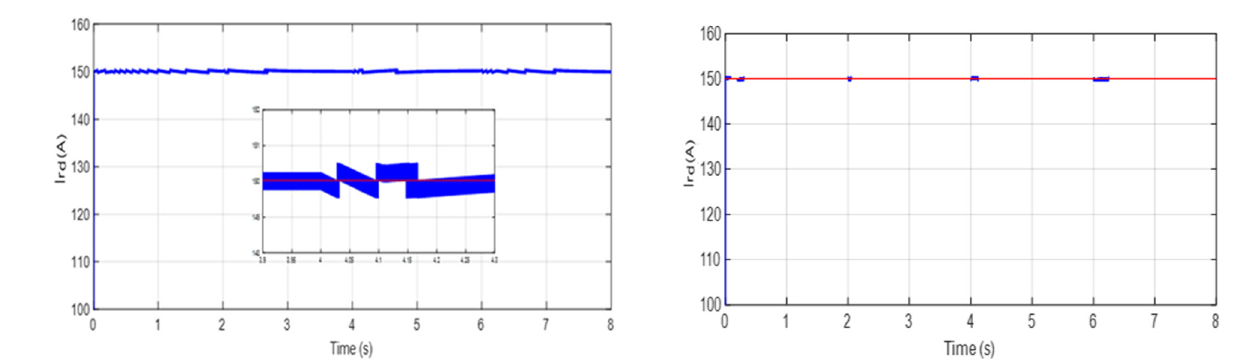
Fig. 15 Current tracking performance for SMC